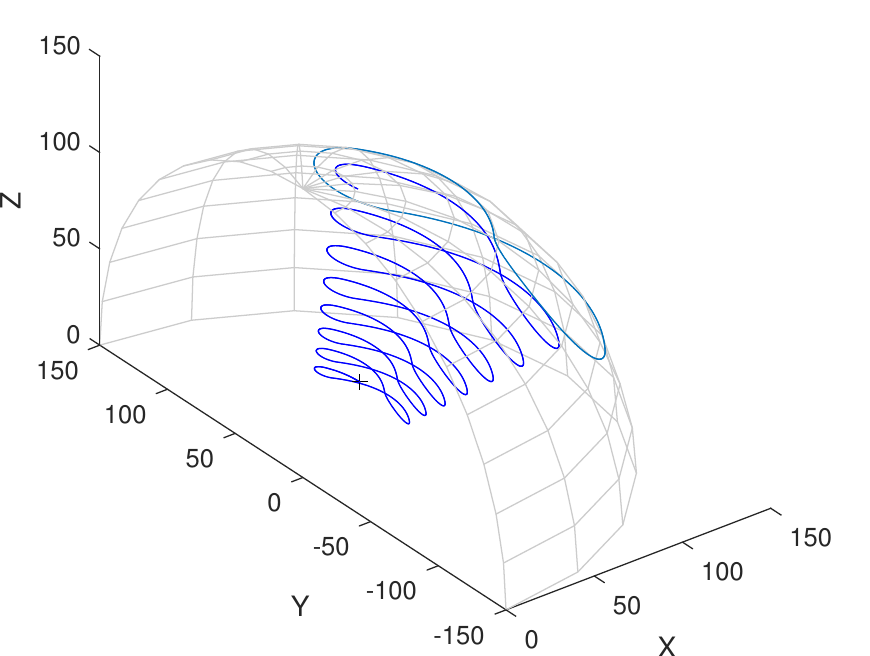
Figure 4. Trajectory of the KM during the traction phase. The remaining simulation results are for the cascade control of the GSM. Figure 5 shows that the winch speed controller based on SMC successfully drags ω w to its desired level ω w in the presence of the input disturbance ζ ( t ) . Due to the use of gears, the direction r of rotation is opposite for the winch and IM. This can be seen in Figure 5 and 6. The control effort T w for the winch speed controller is shown in Figure 7. The discontinuous gain of c the SMC used for the simulations is κ = 150.